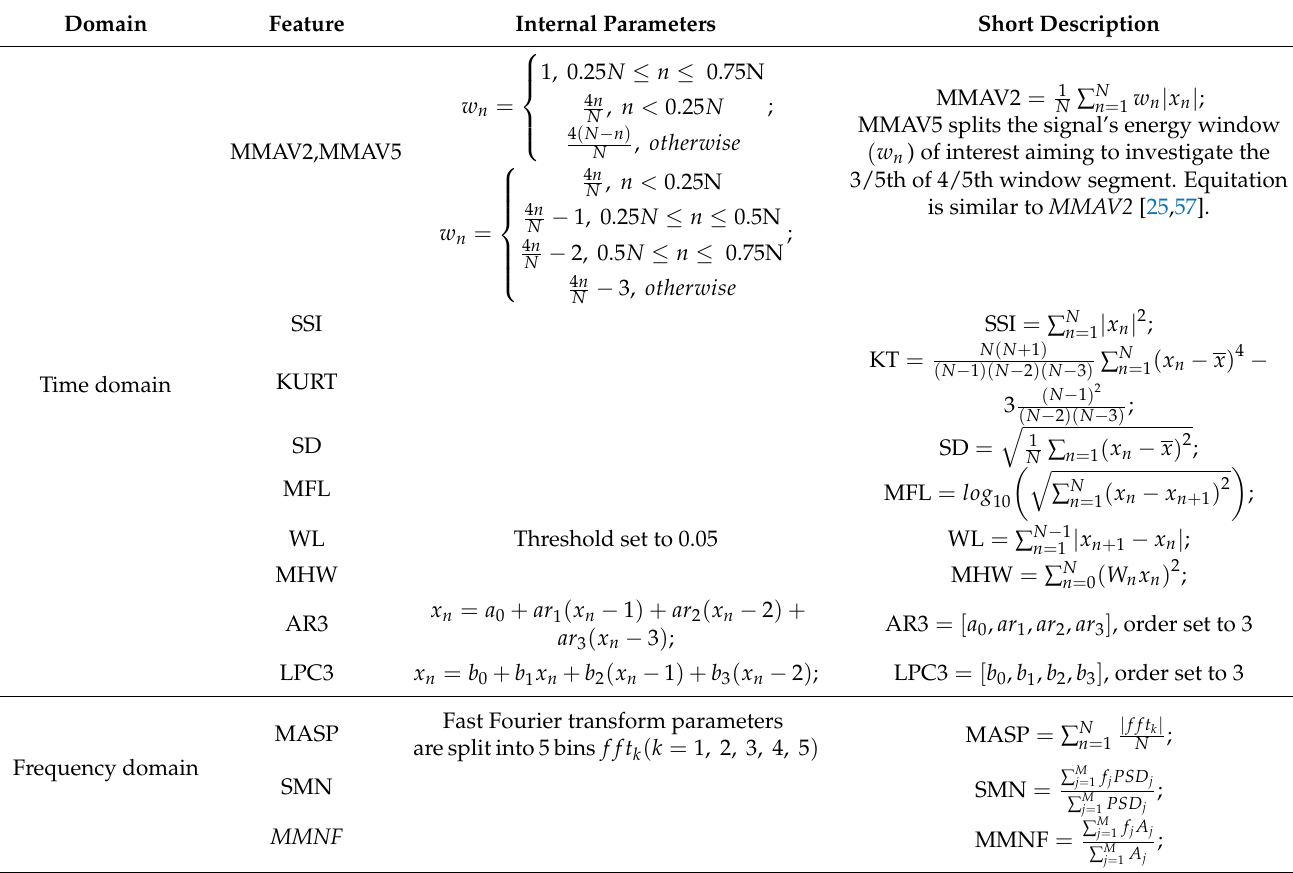
Table 3. Feature additions of the ASF-24P stroke-oriented multidomain feature